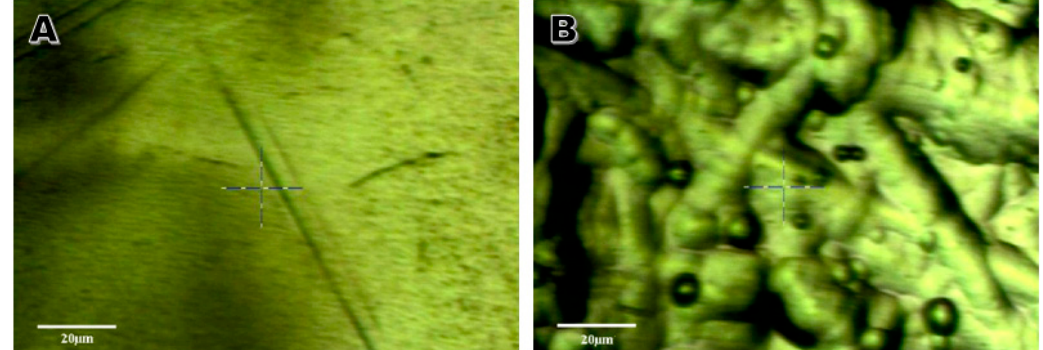
Figure 5. AFM console window view of aluminum samples electropolished with ( A ) an ionic liquid and ( B ) 1 M phosphoric acid, both on a 20 µm scale.